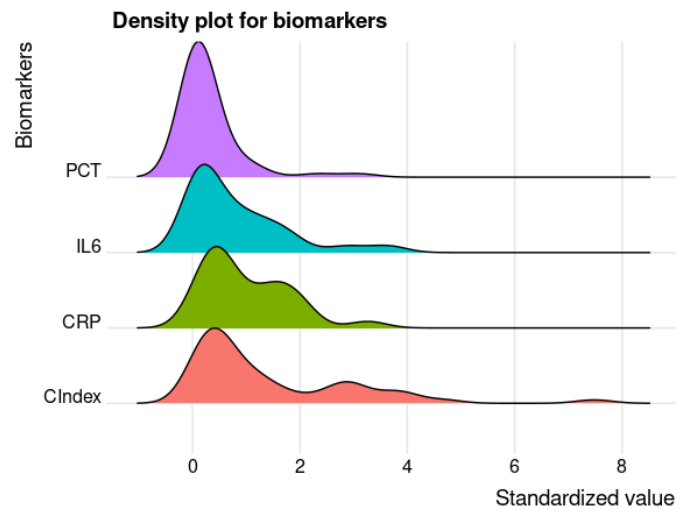
Figure 3. Density plot for PCT, IL − 6, CRP and CIndex. X -axis shows the value for each biomarker normalised by the mean value, while the Y -axis represents the density probability.